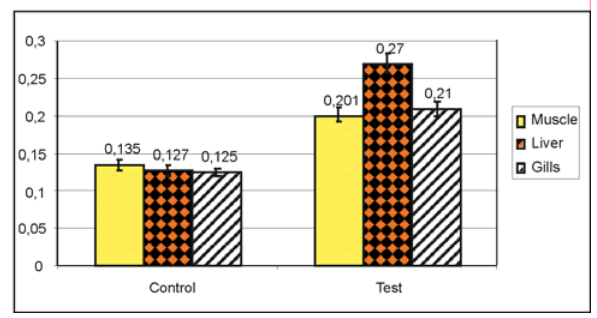
Fig. 6. Lead concentration (mg/kg) in tissues of stone loach